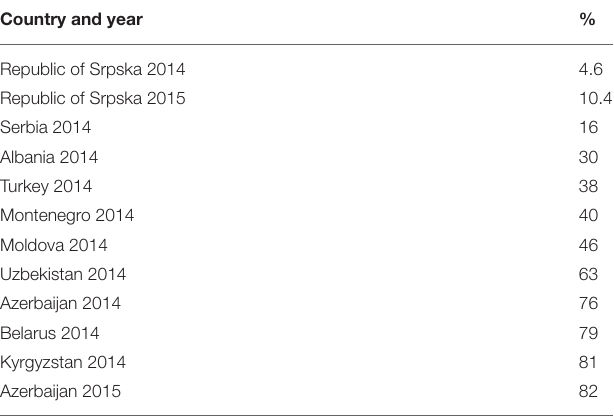
TABLE 5 | Utilization of third and fourth generation cephalosporins as a % of total cephalosporins (J01D) (taken from Fürst et al., 2015; WHO EUROPE, 2017; ECDC,